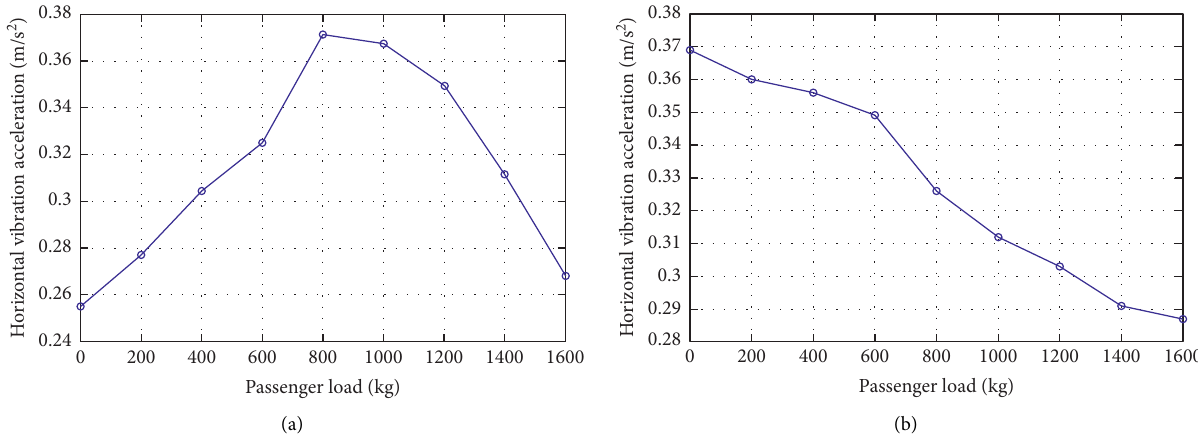
Figure 6: Influence of passenger load on horizontal vibration of the car. (a) k � 1 × 0 5 N/m. (b) k � 300N/m.